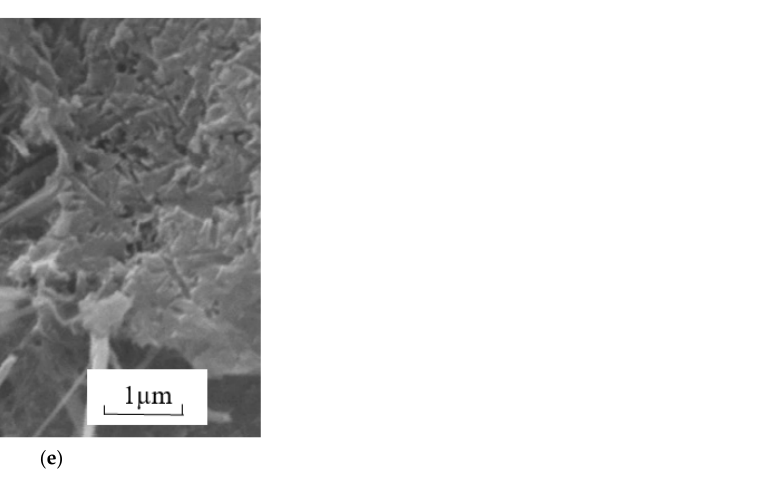
Figure 7. Microstructural changes of the cement with raw ore and high-viscosity ore under 650 ◦ C calcination. ( a ) CS; ( b ) A5; ( c ) B5; ( d ) C5; ( e )